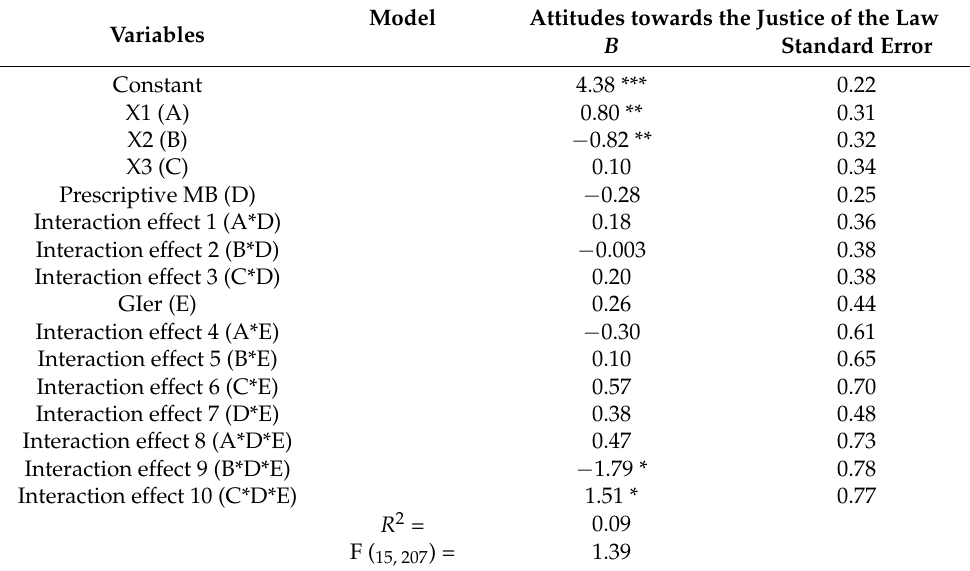
Table 4. Testing the Moderating Effect of Prescriptive MB and Gender on the Relationship between the AAM Type and Attitudes towards the Justice of the